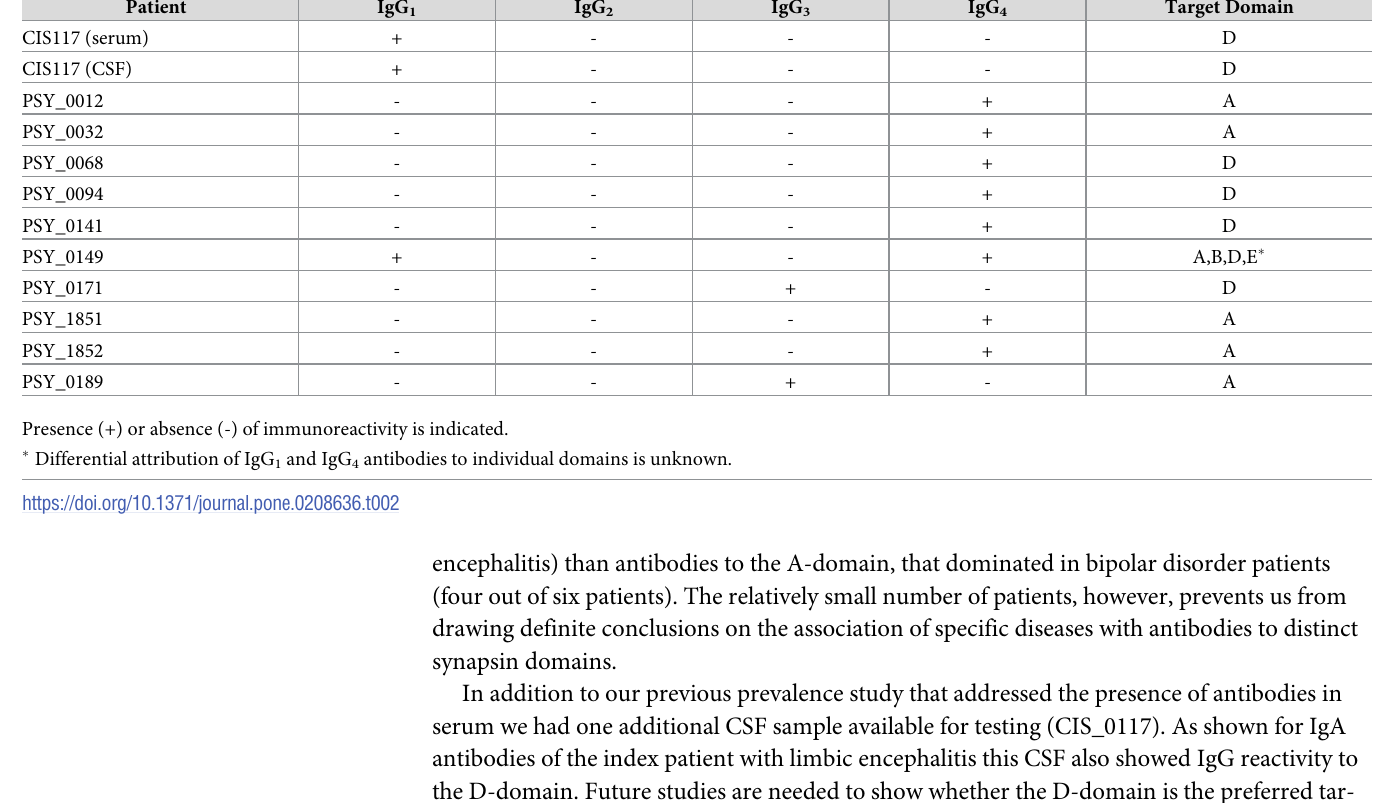
Table 2. Distinct IgG subclasses of antibodies to synapsin Ia.